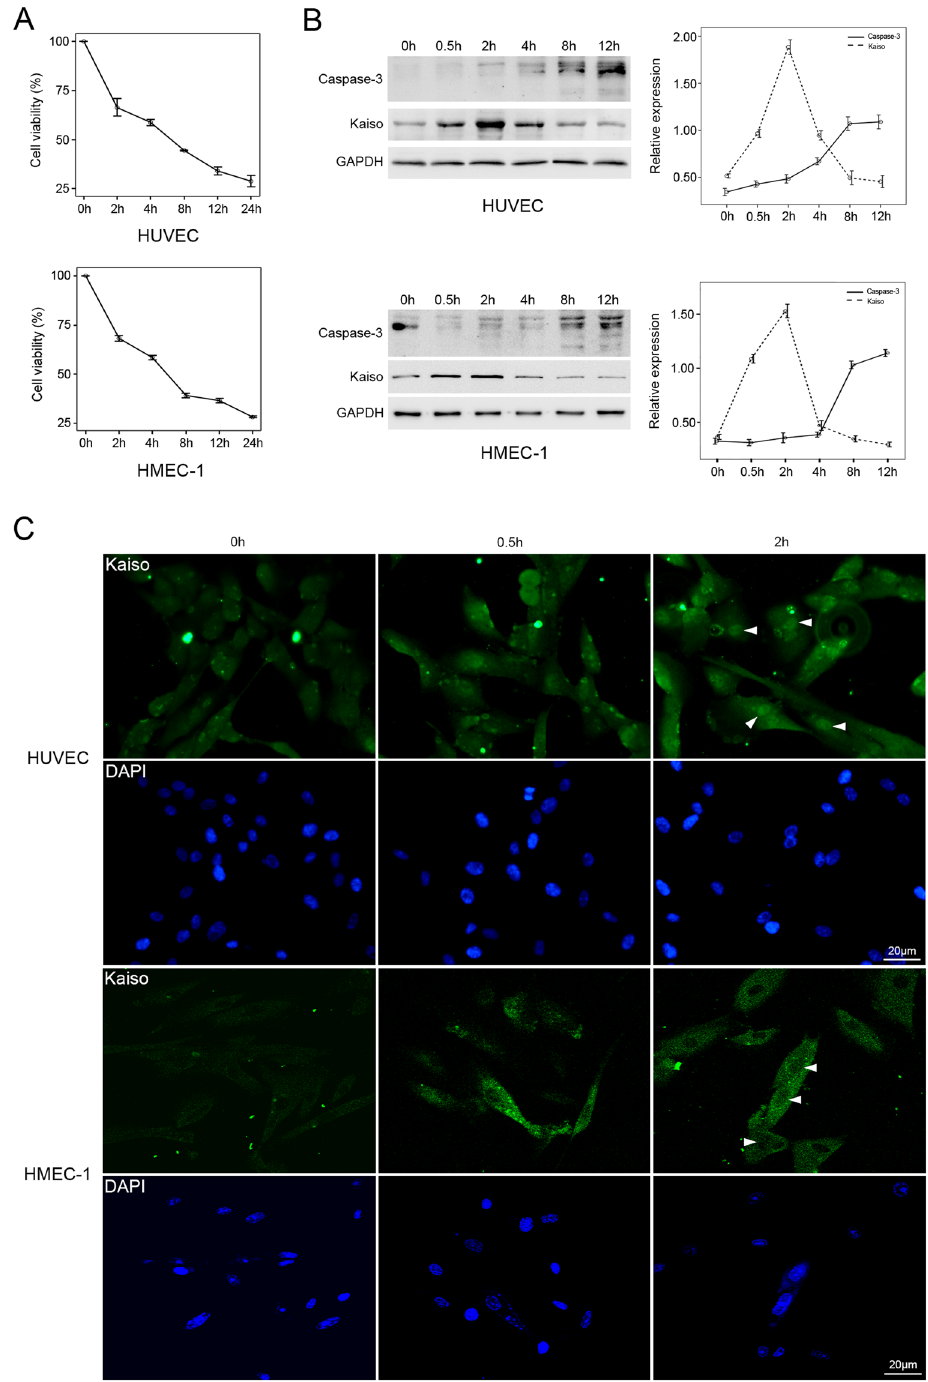
Figure 1. Kaiso expression in H 2 O 2 -treated endothelial cells. Cells were treated with 400 μ M H 2 O 2 for 0, 2, 4, 8, 12, and 24 h and cell viability was analyzed at the end of each time period using CCK8 method ( A ). Results are presented as mean ± SD of triplicate (n = 3) experiments. Cells were treated with 400 μ M H 2 O 2 for 0, 0.5, 2, 4, 8, and 12 h and the protein expressions of Kaiso and Caspase-3 were analyzed using Western blot ( B , left panel). GAPDH served as loading control. Representative curves of relative protein expressions of Kaiso and Caspase-3 are presented as densitometric values corrected by GAPDH ( B , right panel). Experiment was performed in triplicate (n = 3). Cells were treated with 400 μ M H 2 O 2 for 0, 0.5, and 2 h and stained with monoclonal mouse anti-Kaiso 6F/6F8-CHIP grade antibody ( C ). Cell nuclei were stained with DAPI. Arrowheads show the nuclear expression of Kaiso. Scale bar represents 20 μ